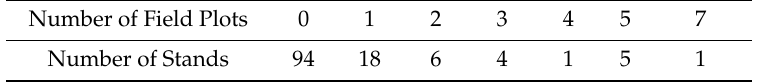
Table 1. Distribution of the number of stands by stand-specific sample size. A given column indicates the number of stands that contain the number of field plots indicated in the top row. For example, the first column indicates there are 94 stands with 0 field